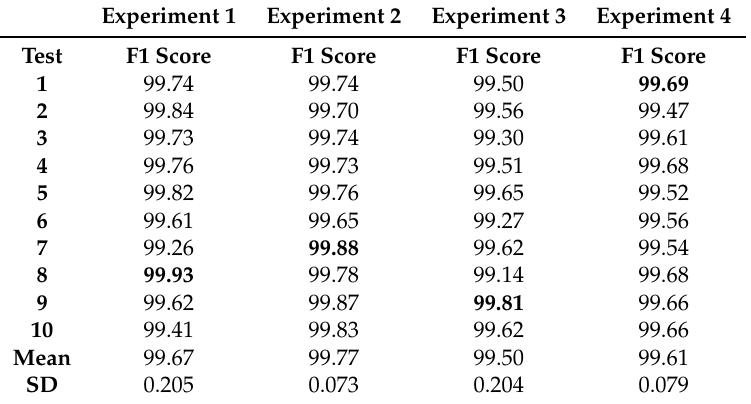
Table 6. Experiments results of ten tests in percentages. Abbreviations. SD: standard